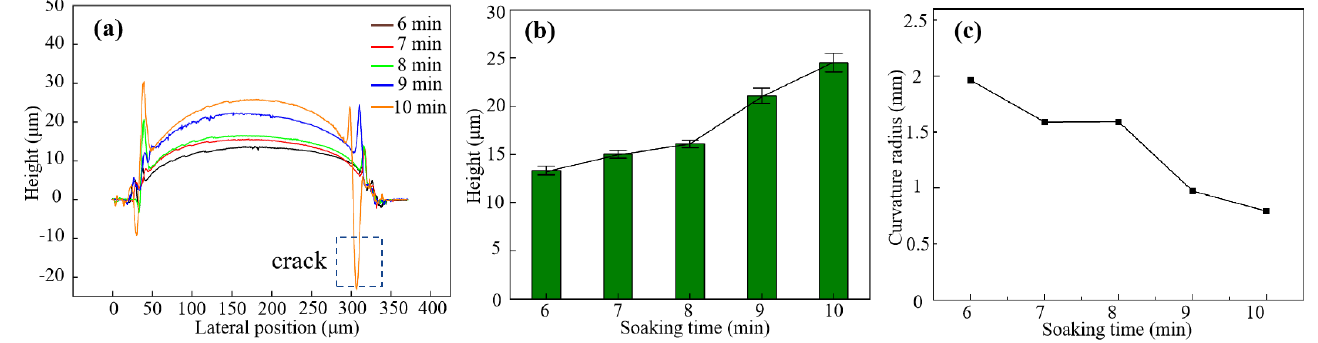
Figure 9. ( a ) Profiles, ( b ) maximum heights, and ( c ) curvature radii of microlenses under various soaking time.